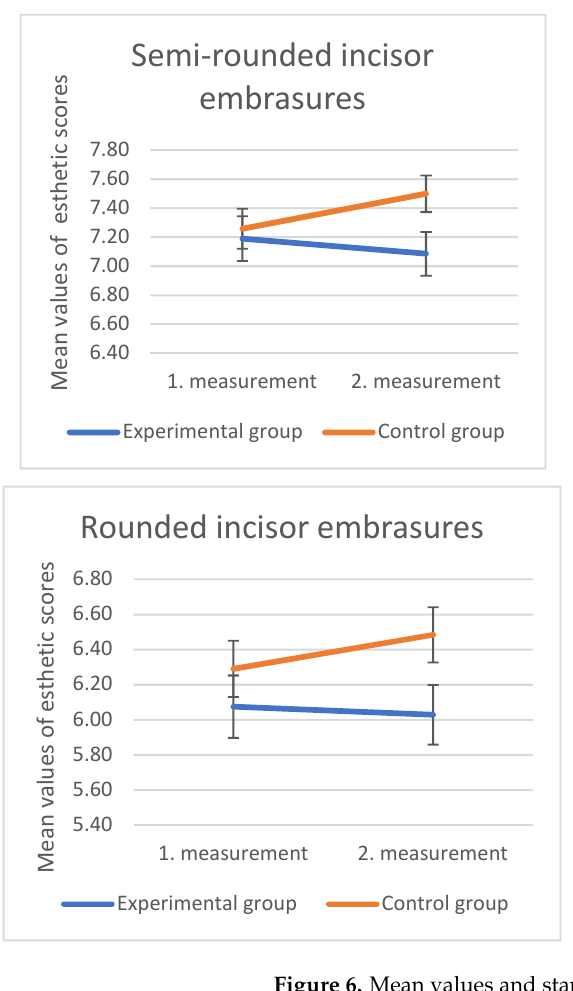
Figure 6. Mean values and standard errors (error bars) of the ratings of the control and experimental groups for photographs showing semi-rounded, squared, and rounded incisor embrasures, in the first and second measurements.